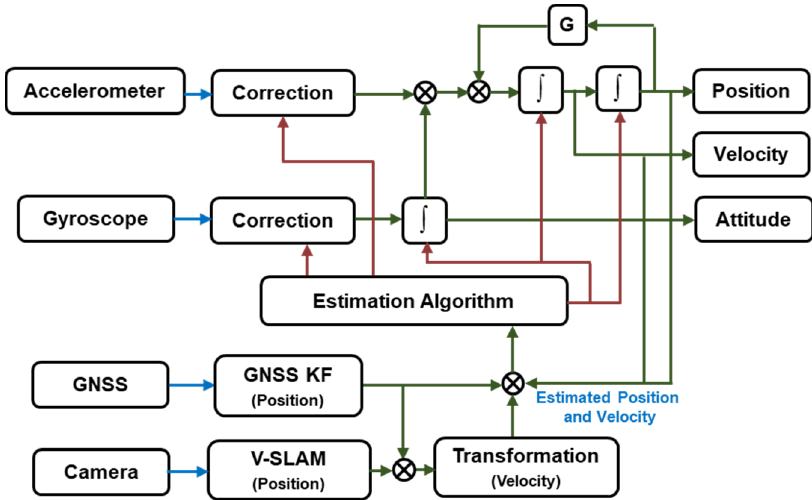
Figure 1. Inertial navigation system (INS)/global navigation satellite system (GNSS)/visual Figure1. Inertialnavigationsystem(INS) / globalnavigationsatellitesystem(GNSS) / visualsimultaneous simultaneous location and mapping (V-SLAM) integration scheme. location and mapping (V-SLAM) integration